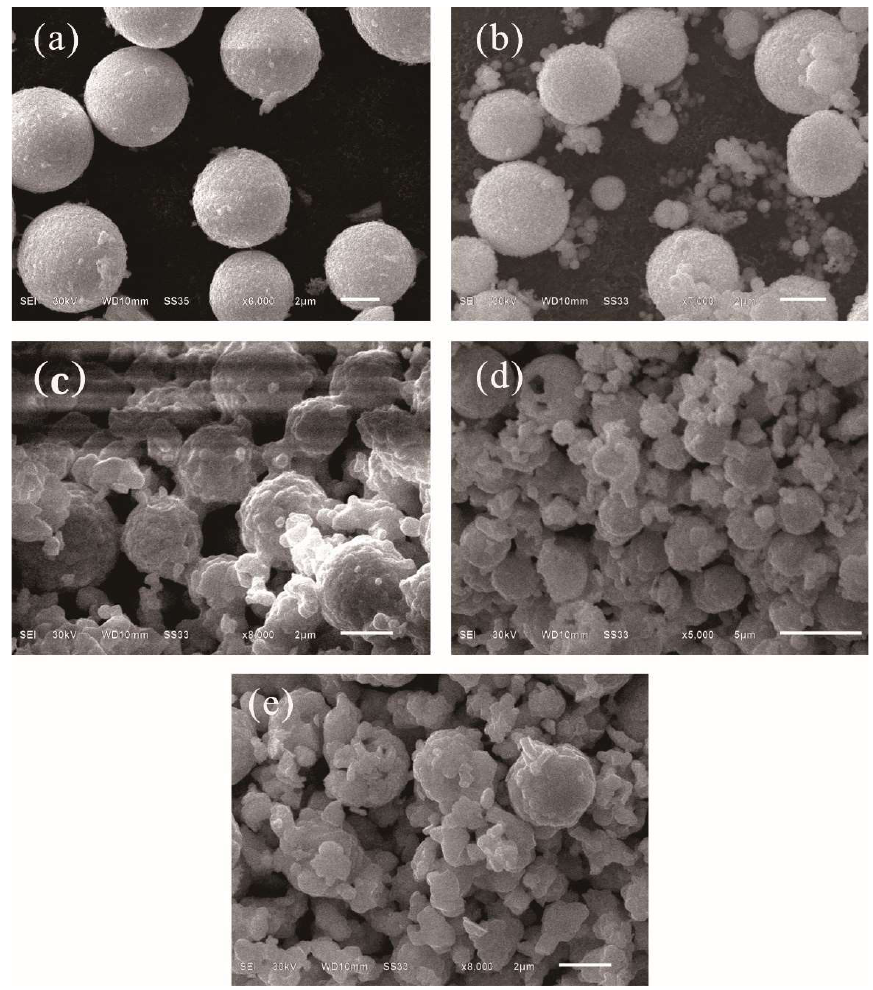
Figure 2. Scanning electron microscope (SEM) images of ( a ) CuBi 2 O 4 ; ( b ) CuBi 2 O 4 @C; ( c ) CuBi 2 O 4 / β -Bi 2 O 3 (1:2.25, 400 °C); ( d ) CuBi 2 O 4 / β -Bi 2 O 3 (1:2.25, 600 °C); ( e ) CuBi 2 O 4 / β -Bi 2 O 3 (1:2.25, 800 °C).